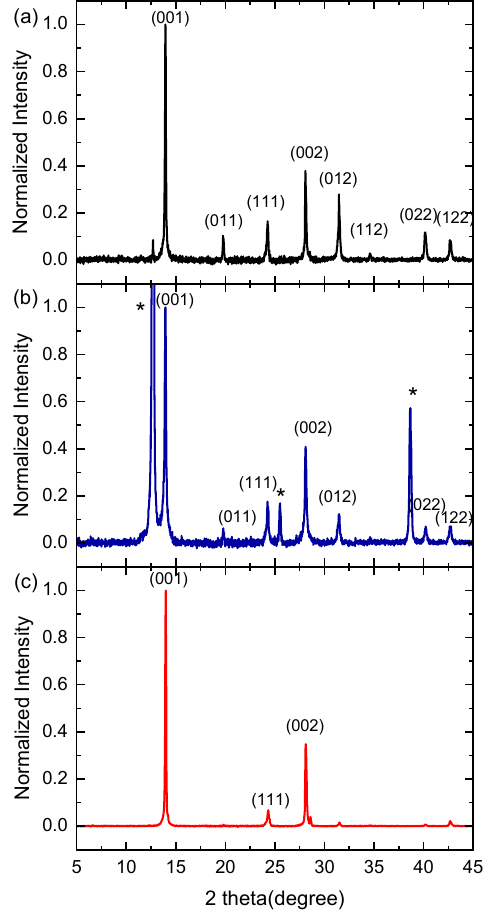
Figure 3. Normalized X ‐ ray (XRD) patterns of the thin film perovskite FAPbI 3 prepared on fused silica by two ‐ step method using various solvents for FAI: ( a ) IPA, ( b ) n ‐ BuOH and ( c ) t ‐ BuOH (* correspond to PbI 2 ).